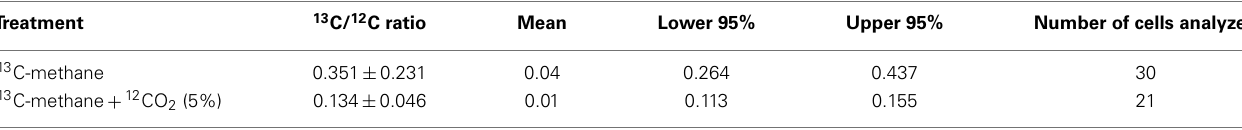
Table 1 | 13 Carbon enrichment of Methylosinus trichosporium OB3b cells grown on 13 C-labeled methane with or without additional supplementation with unlabeled carbon